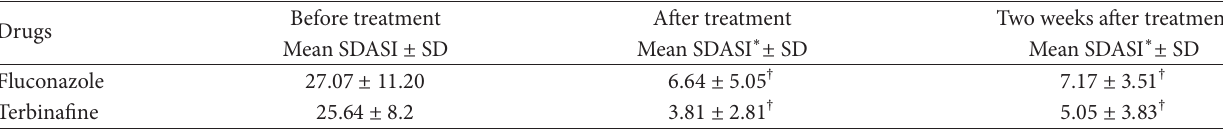
Table 1: Comparison of mean SDASI in three phases